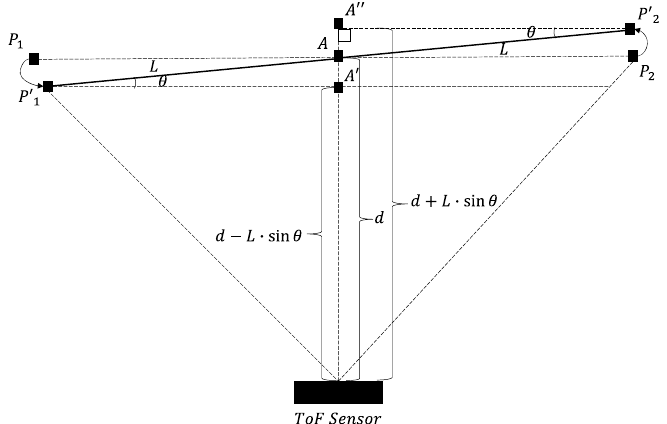
Figure 5. Top view of an object rotated with respect to the image plane of the ToF sensor.